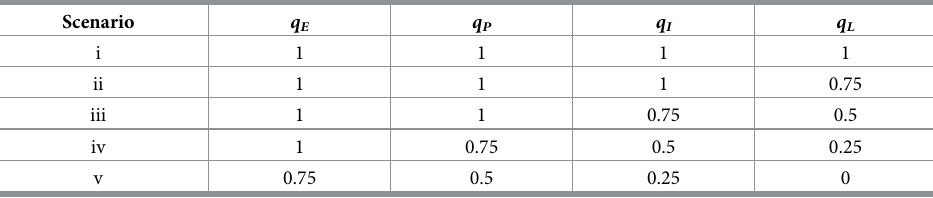
Different scenarios for susceptibility to successive infections in different stages of the